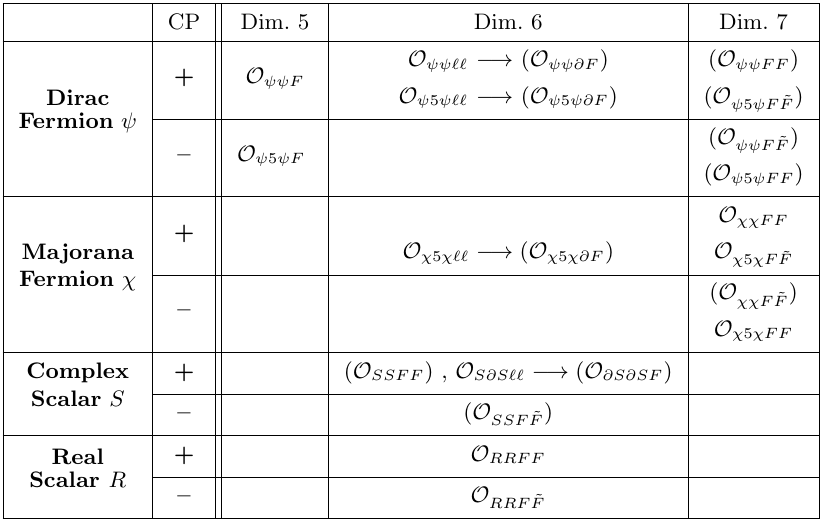
Table 1 . Relevant Dark Matter-photon operators at the UV scale (cid:3). Operators in round brackets give a subleading contribution to signals in direct and indirect searches, compared to operators with the same CP quantum numbers, or are dominantly generated in the IR by other operators via RG evolution, denoted by . In subsequent sections, we set limits only on those operators (cid:0)! which are not in brackets (except for and , whose limits we will show for illustrative O (cid:31) 5 (cid:31)@F O @S@SF